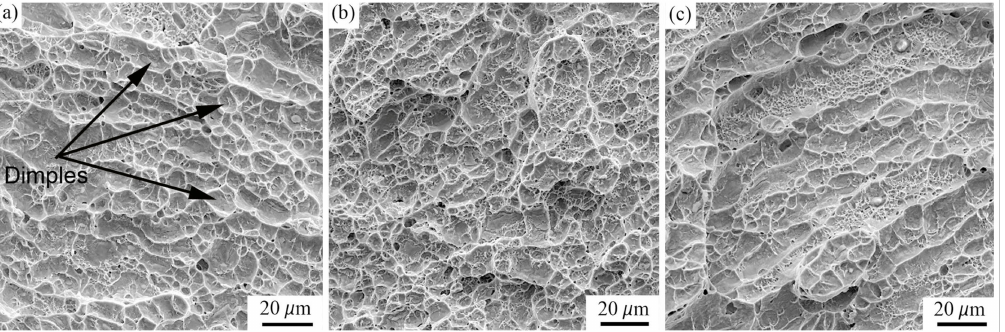
Figure 17. Fracture surfaces of the dissimilar SS304L/IN718 welded joints in the ( a ) as-welded ST, ( b ) STA, and ( c ) PWHT